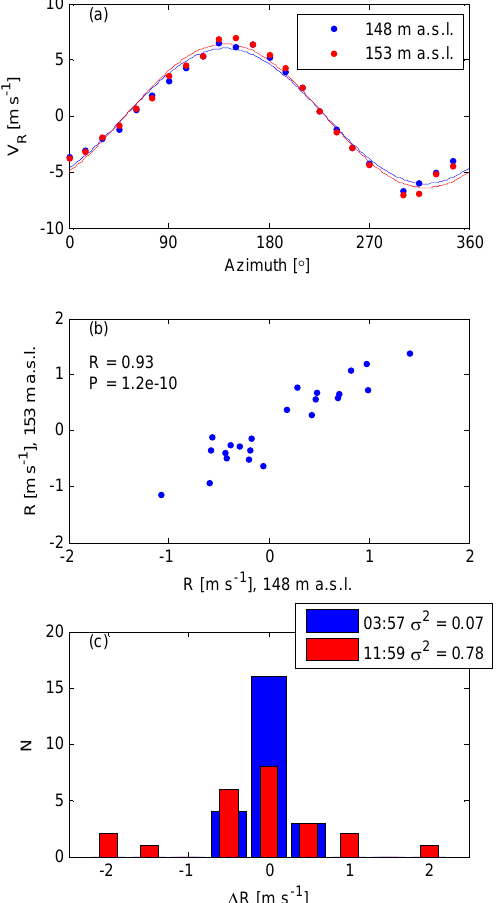
Figure 2. (a) Radial wind speed and sinusoidal fit on 24 August 2013 at 03:57 (UTC) for two consecutive altitudes from a 10 ◦ el- evation angle VAD scan. (b) Scatterplot of the residuals of the fit presented in panel (a) . (c) Histogram of the difference of resid- uals at 148 and 153ma.s.l. altitudes from a 10 ◦ elevation angle VAD scan for a calm period (03:57UTC) and a turbulent period (11:59UTC) with corresponding variances indicated in the legend. The σ 2 υ (Eq. 6) is 0.03 at 03:57UTC and 0.04 at